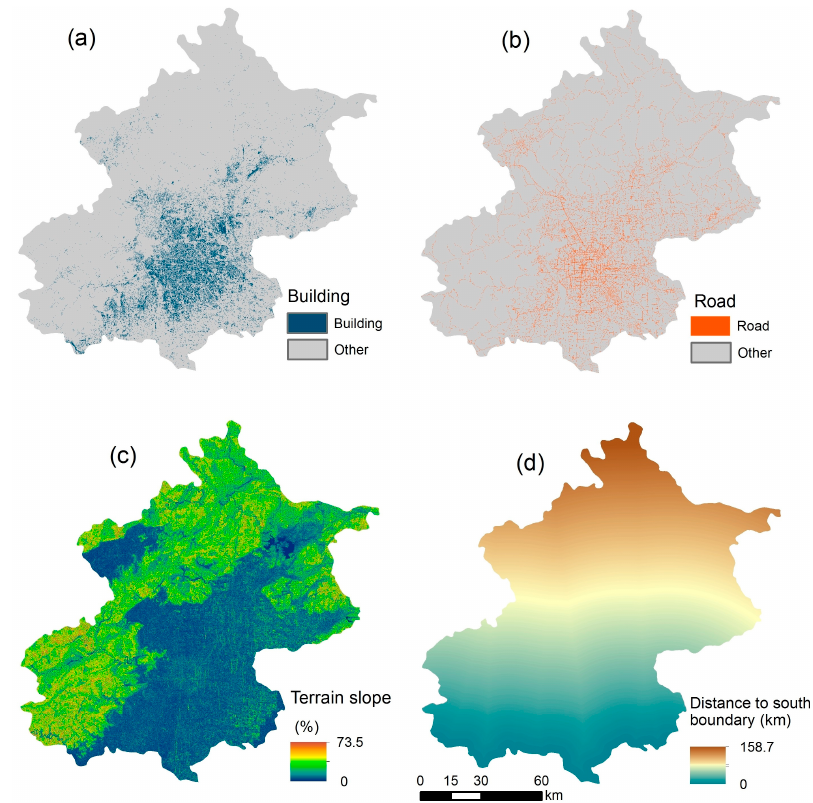
Figure 1. Some of the prepared land use variables. ( a ) building; ( b ) major road; ( c ) terrain slope; and ( d ) distance to the south boundary.